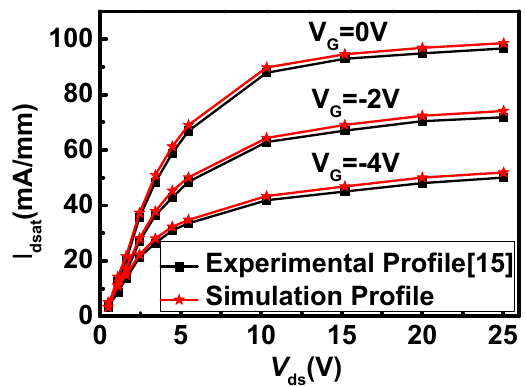
Figure 2. Comparison of experimental data and simulation data on output current.